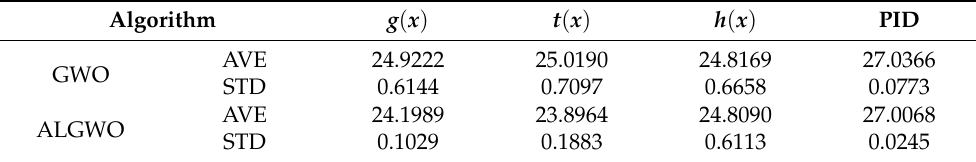
Table 8. The comparison of final fitness of algorithms on test system 5.